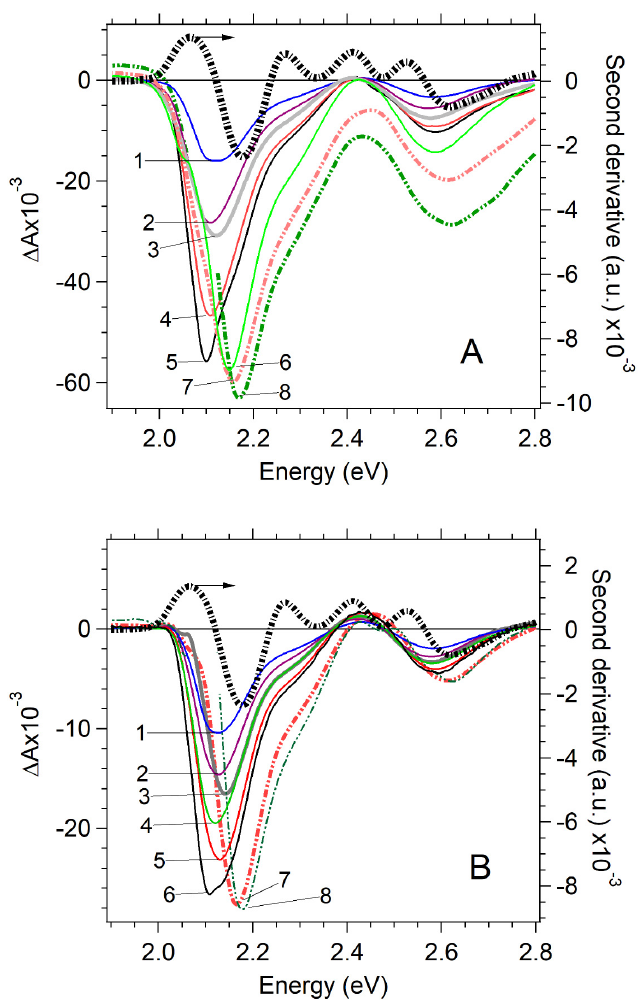
Figure 1. Dependence of transient absorption spectra of CdSe on the pump pulse fluence (left axis) at a short time delay of 100 fs and a long time delay of 500 ps. The second derivative of the CdSe absorption spectrum (black dashed line, right axis). Second derivative minimums demonstrate the position of exciton bands of the absorption spectrum. ( A ) Transient spectra at a time delay of 100 fs: 1, 0.042 mJ/cm 2 ; 2, 0.064 mJ/cm 2 ; 3, 0.085 mJ/cm 2 ; 4, 0.18 mJ/cm2; 5, 0.25 mJ/cm 2 ; 6, 0.35 mJ/cm 2 ; 7, 1.06 mJ/cm 2 ; 8, 1.8 mJ/cm 2 . ( B ) Transient spectra at a time delay of 500 ps: 1, 0.042 mJ/cm 2 ; 2, 0.064 mJ/cm 2 ; 3, 0.085 mJ/cm 2 ; 4, 0.18 mJ/cm 2 ; 5, 0.25 mJ/cm 2 ; 6, 0.35 mJ/cm 2 ; 7, 1.06 mJ/cm2; 8, 1.8 mJ/cm 2 .